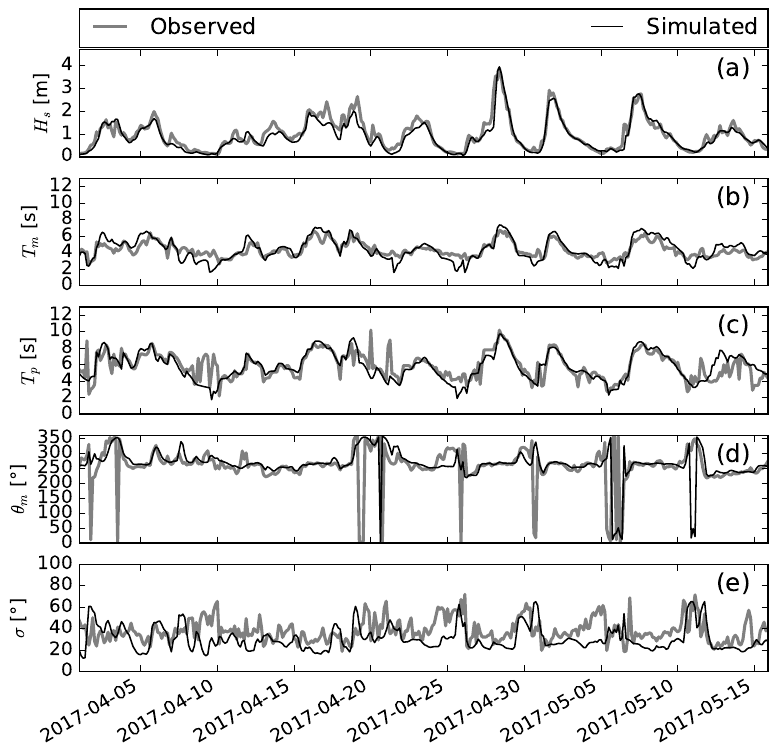
Figure 7. Comparisons between measurements and predictions of spectral bulk wave parameters at La Revellata buoy. H s : significant wave height ( a ); T m : mean period ( b ); T p : peak period ( c ); θ m : mean wave direction ( d ); σ : wave directional spread ( e